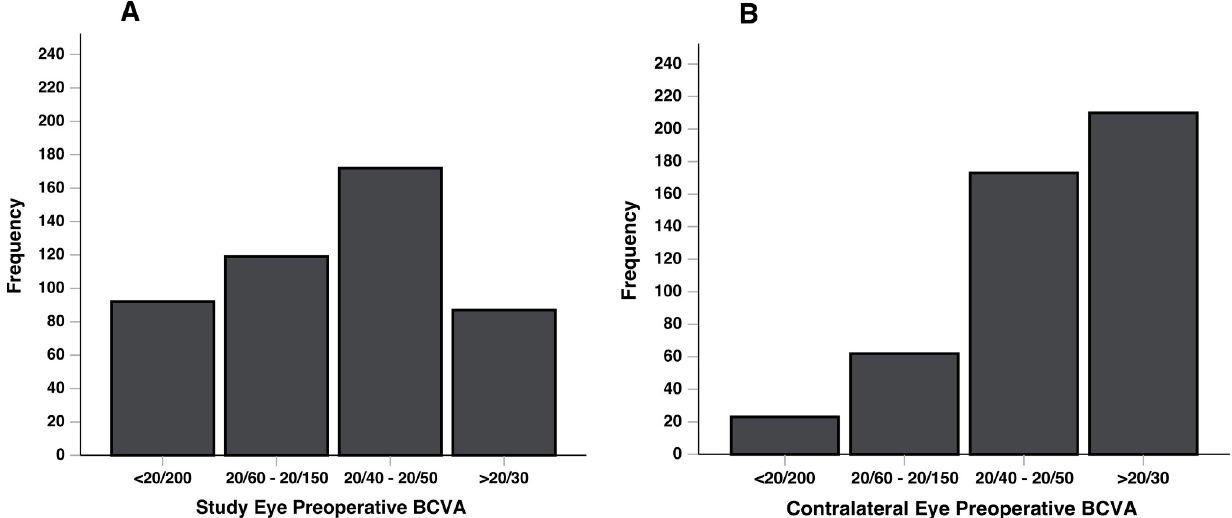
Fig 1. Study eye (A) and contralateral eye (B) preoperative best-corrected visual acuity